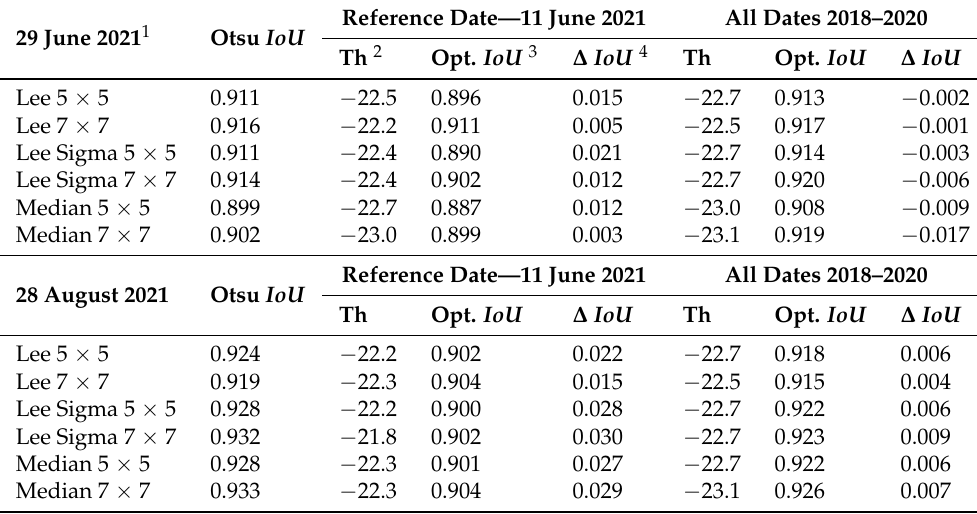
Table 4. Comparison of the accuracy of SAR water masks generated by the Otsu method and the proposed method based on the optimal thresholds of the reference date and the averaged